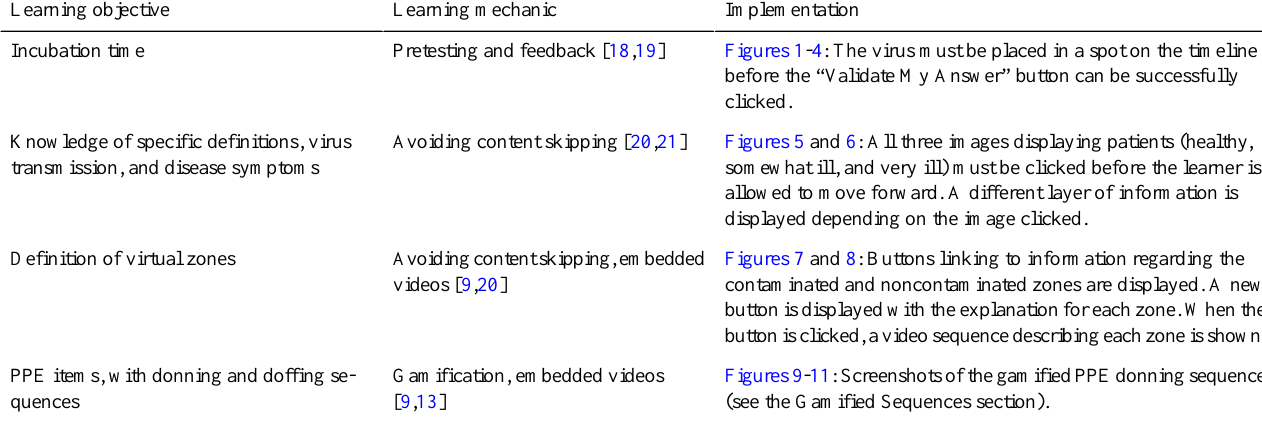
Table 1. Learning objectives, learning mechanics with references, and related implementation examples.